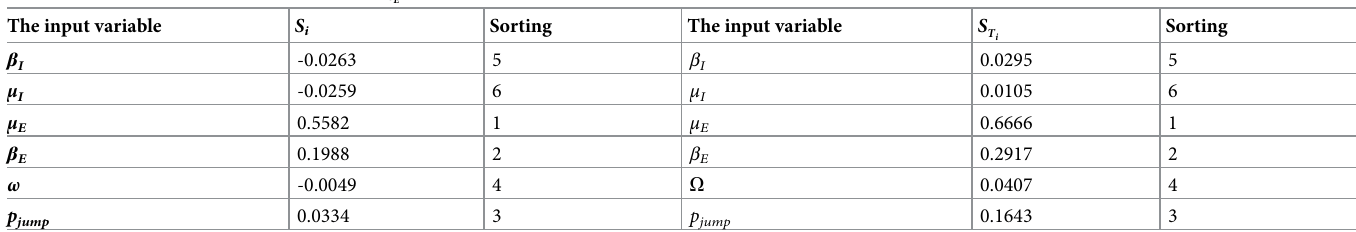
Table 4. Sensitivity index of each variable to ρ